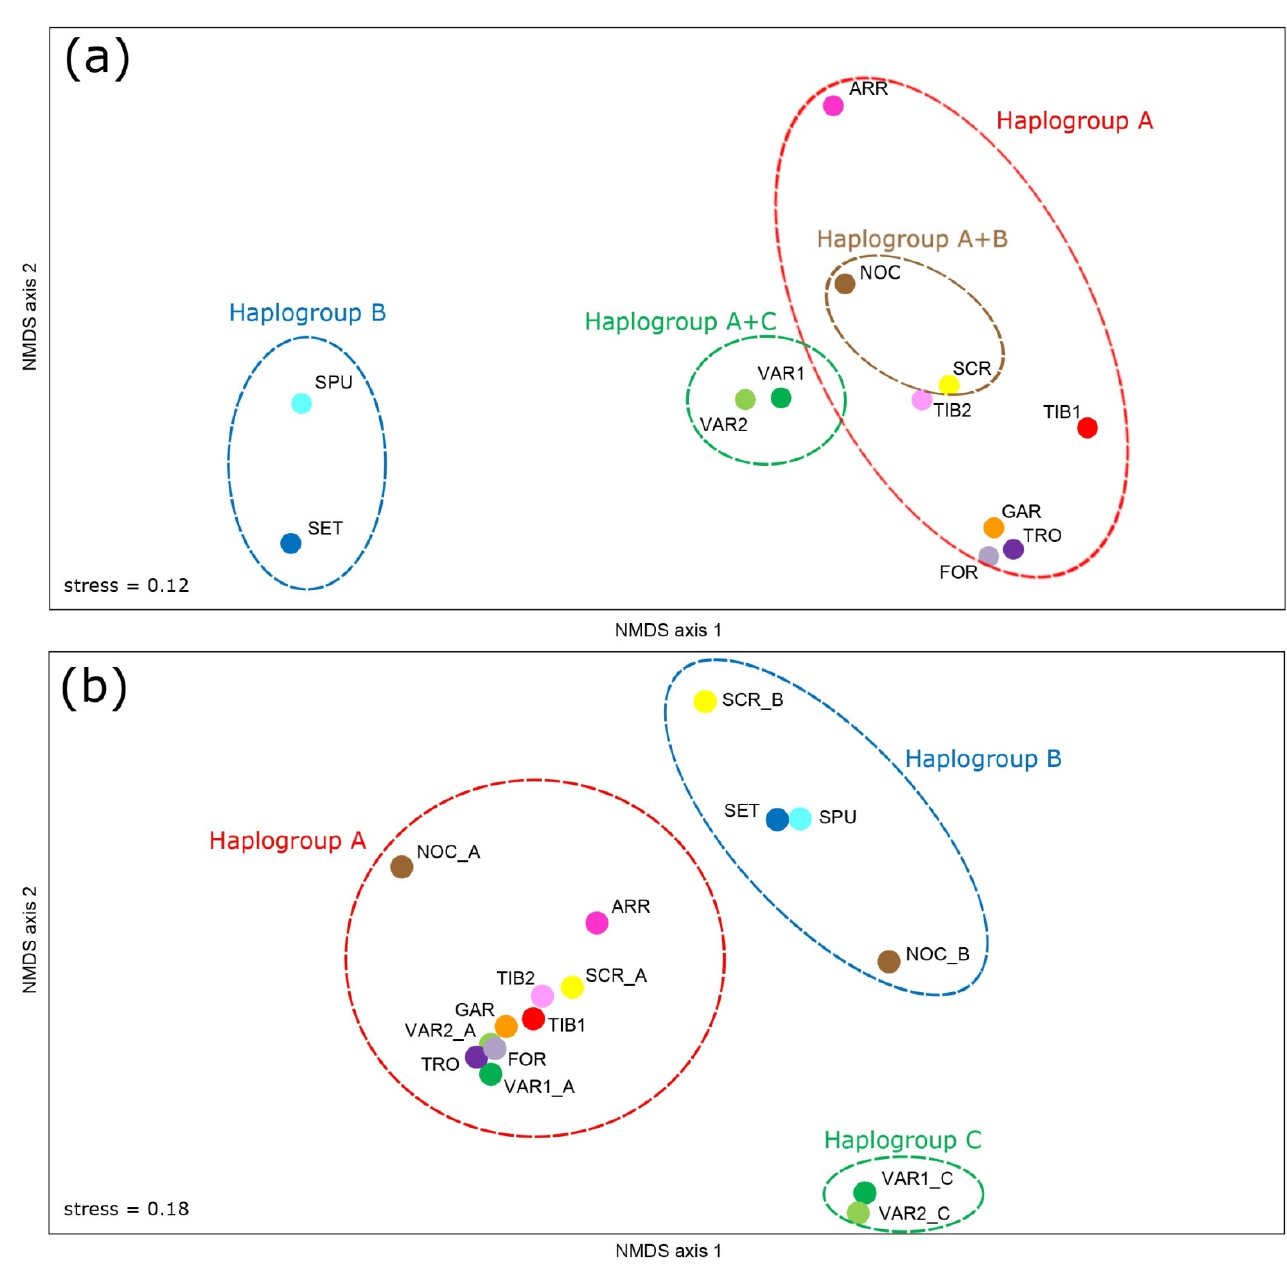
Figure 4. Non-metric multidimensional scaling based on CR matrix of Φ ST on ( a ) sampling sites, ( b ) splitting individuals by haplogroup when two haplogroups occur in the same site (in VAR, SCR, NOC). Populations colors and abbreviations as in Figure 1.